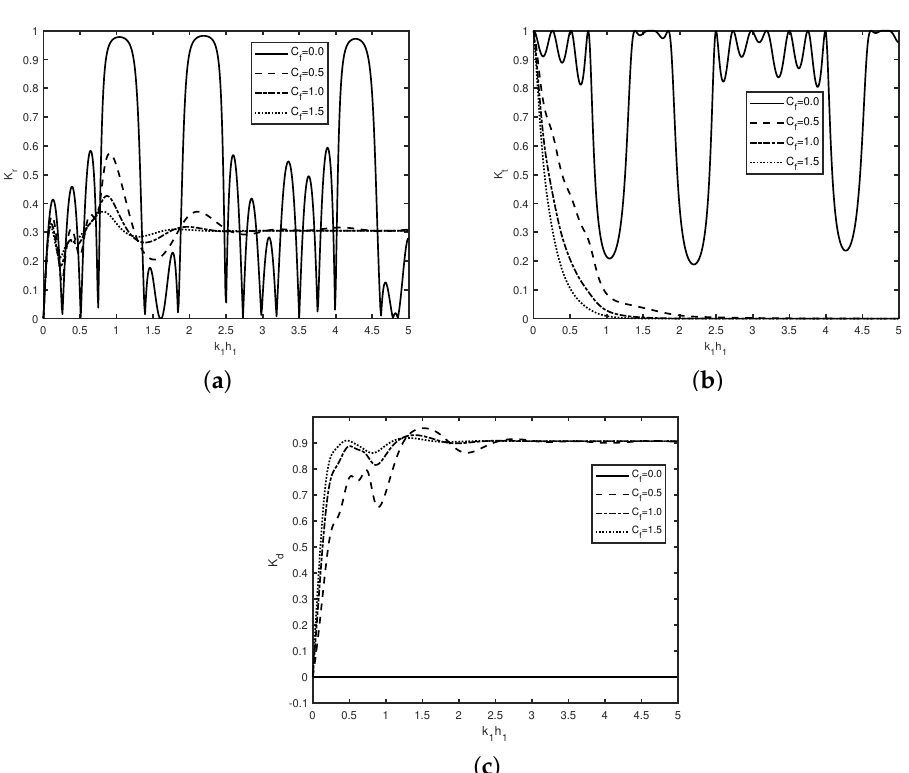
Figure 3. Variation of ( a ) reflection coefficient K r , ( b ) transmission coefficient K t , and ( c ) dissipa- tion coefficient K d versus wavenumber k 1 h 1 for different C f with N = 4, w / h 1 = 1.0, d / h 1 = 2, θ = 20 ◦ , h 2 / h 1 = 0.25, h 1 = 5